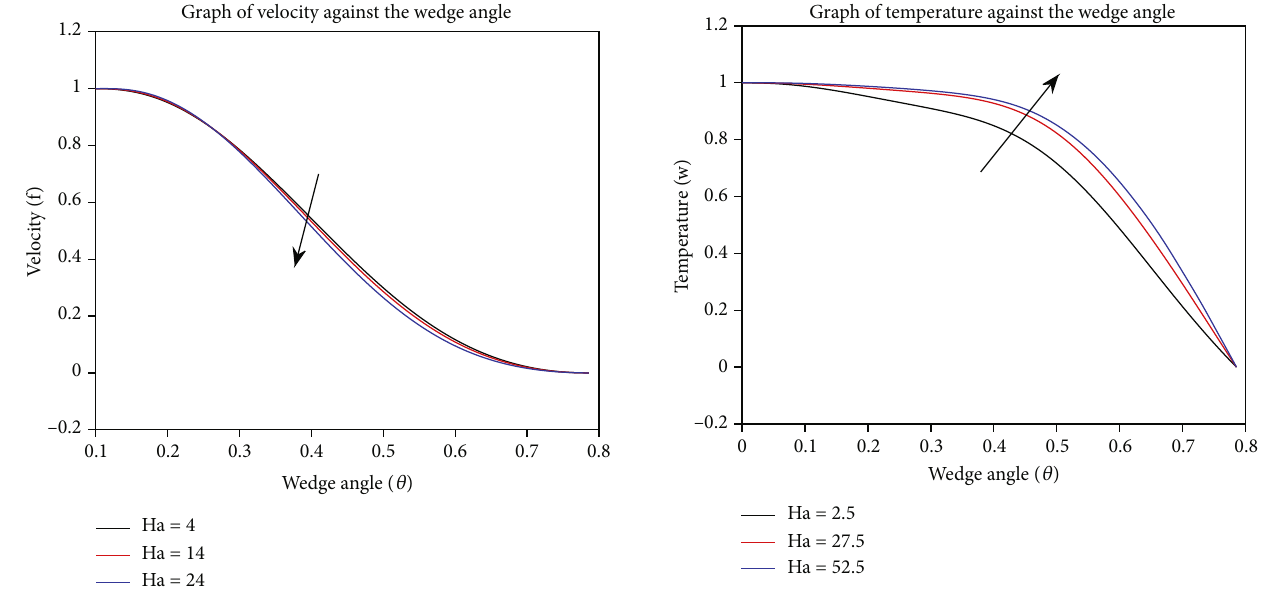
Figure 9: E ff ect of varying the Hartmann number on temperature.